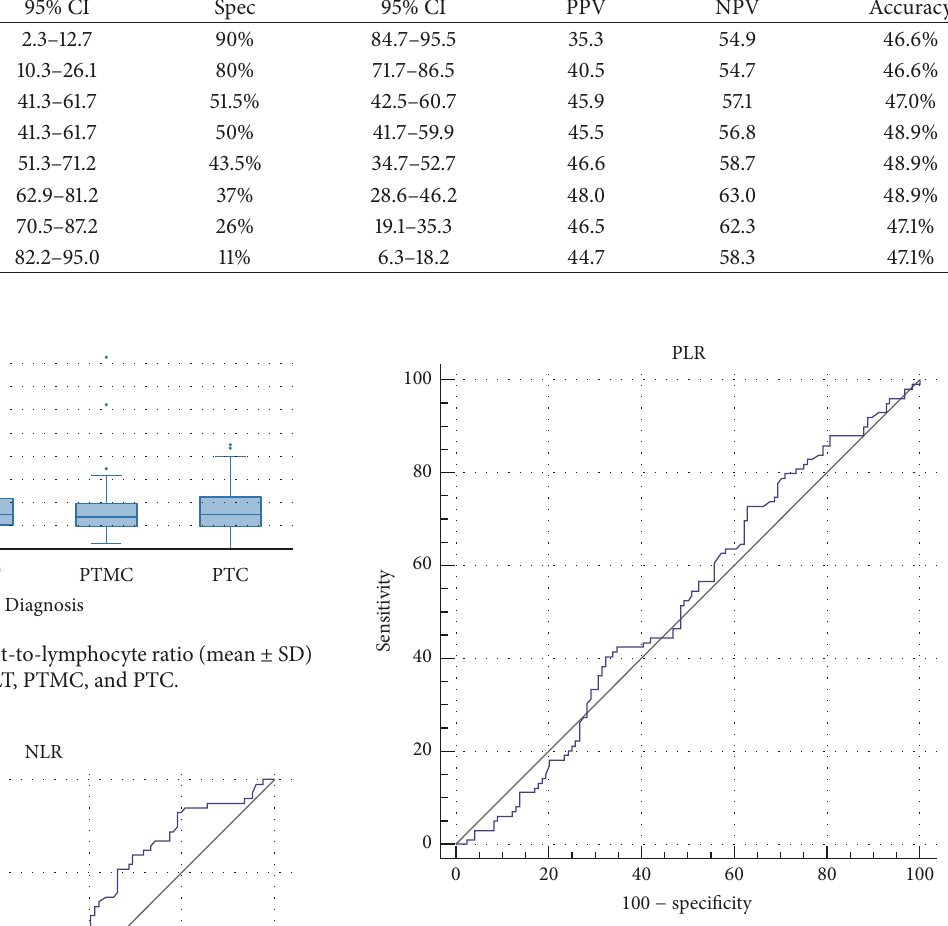
Figure 4: ROC curve for platelet-to-lymphocyte ratio.